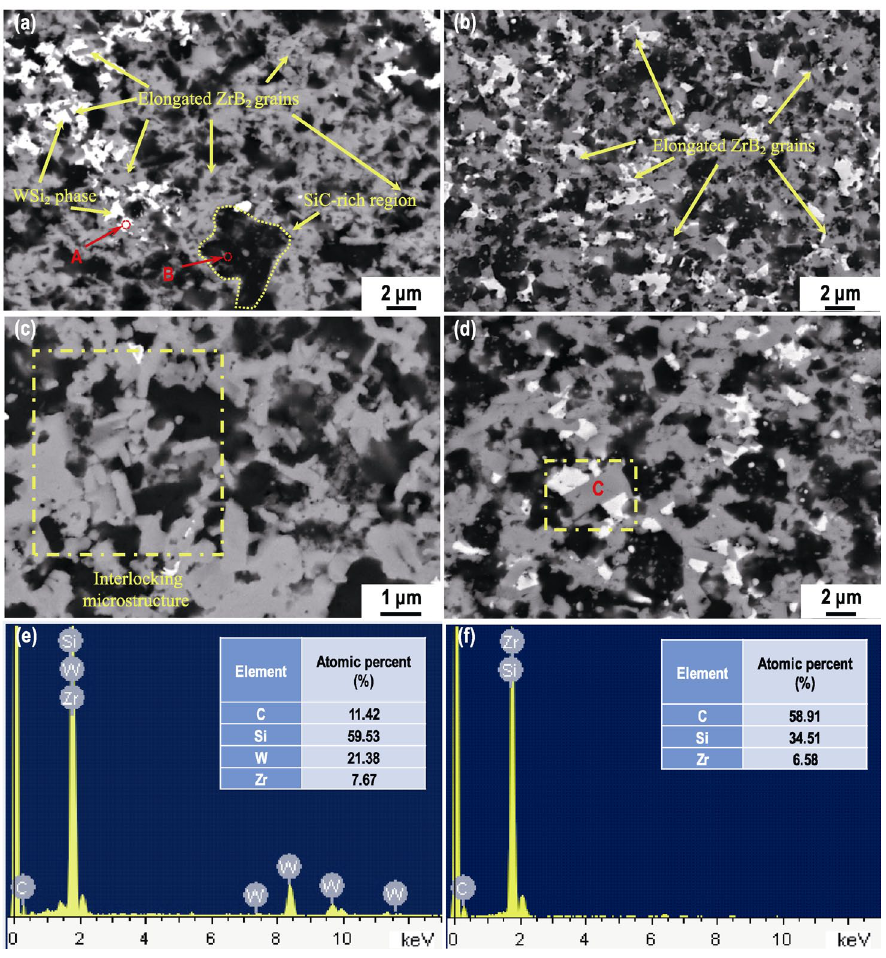
Fig. 5 BSE images of the ZrB 2 –SiC based composites on the polished surface: (a) RZSZ-15, (b) RZSZ-20, (c) high magnification image of RZSZ-20, and (d) RZSZ-25. EDS analysis taken from (e) the zone A and (f) the zone B in (a). The EDS analysis was performed on these